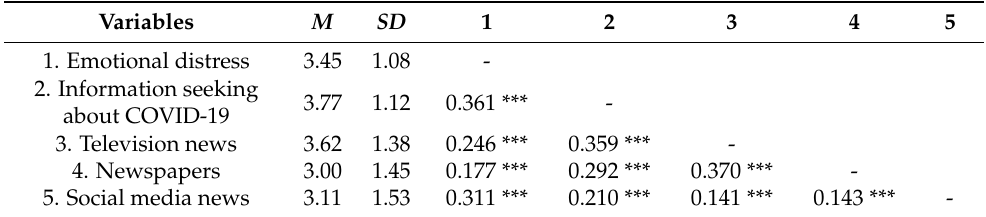
Table 1. Descriptive statistics and